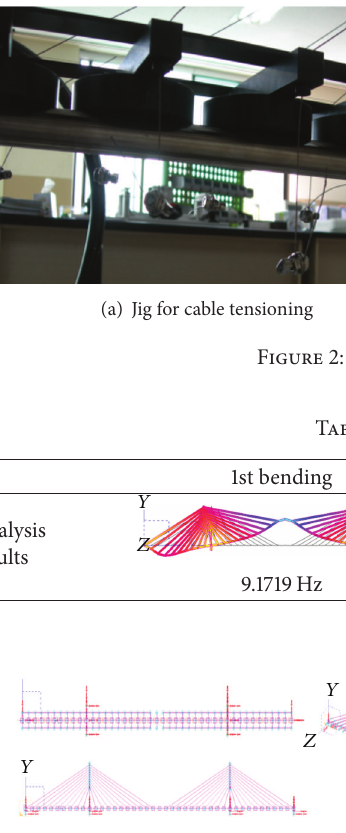
Figure 3: Initial FE modeling of the model bridge using I-DEAS.